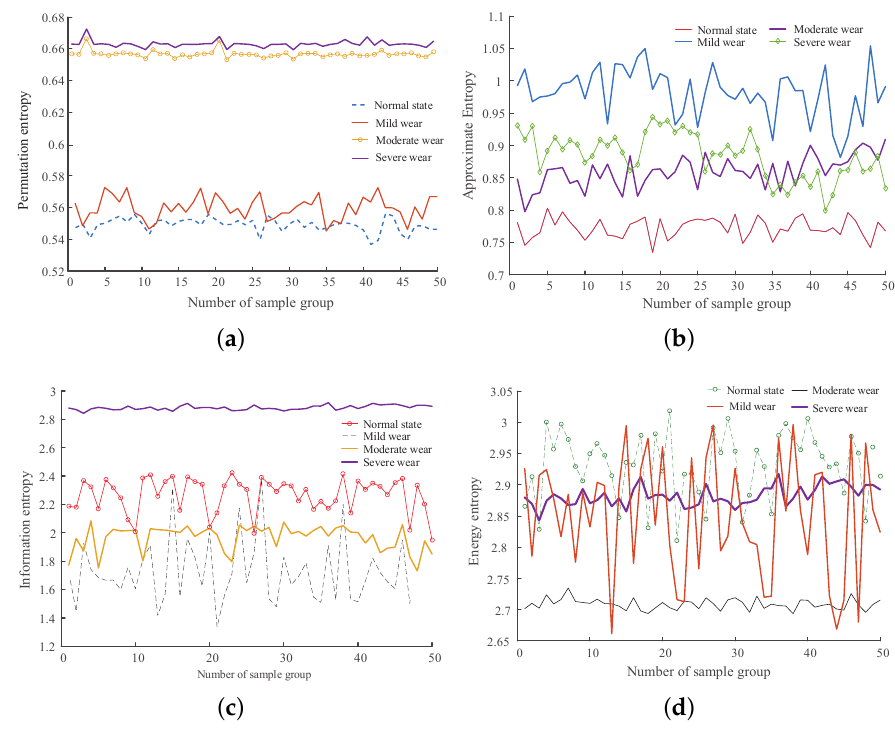
Figure 7. Entropy characteristics of four wear states. ( a ) permutation entropy in different wear states; ( b ) approximate entropy under different wear states; ( c ) information entropy under different wear states; ( d ) energy entropy under different wear conditions.